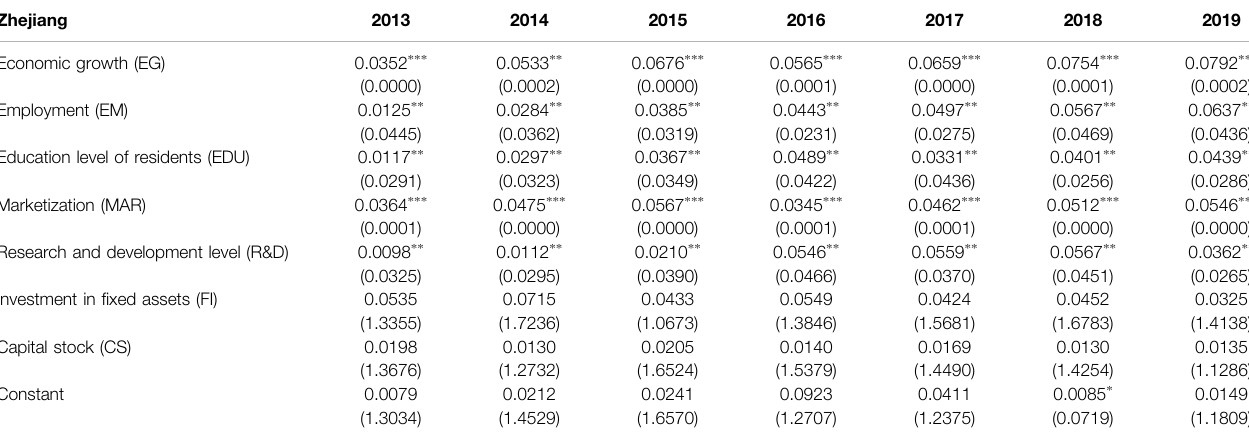
TABLE 13 | Driving force of Zhejiang health tourism industry convergence. Zhejiang